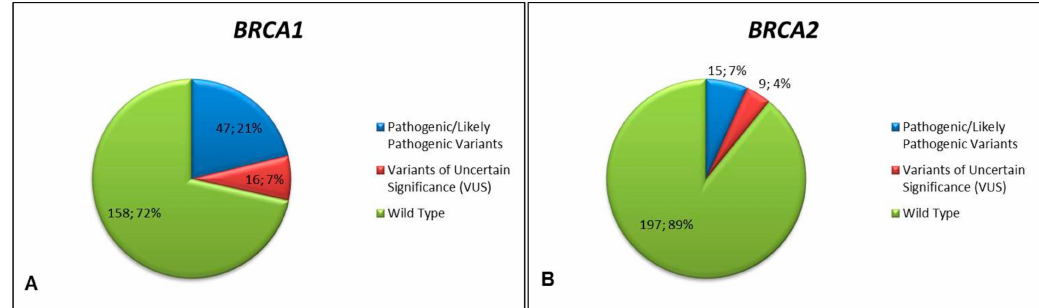
Figure 1. Tumor BRCA1 ( A ) and BRCA2 ( B ) status in the study cohort according to variant classification. Pie charts representing the distribution (number of cases; percentage) of BRCA1 ( A ) and BRCA2 ( B ) variants among the 221 successfully analyzed. Variant classification is color-coded according to the legend on the right.